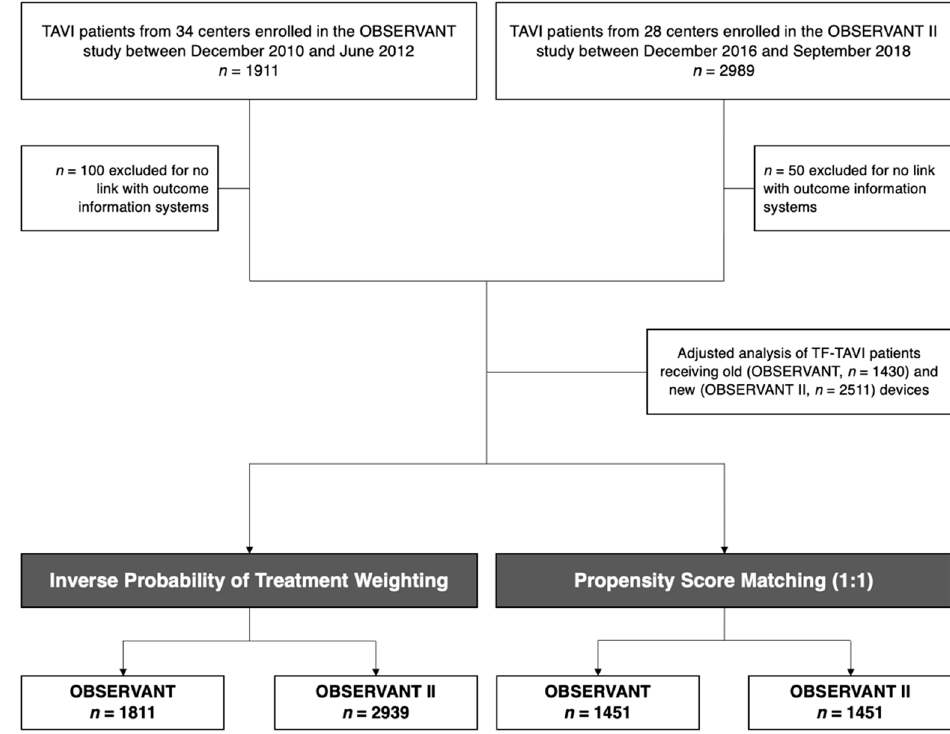
Figure 1. Study participants flowchart.